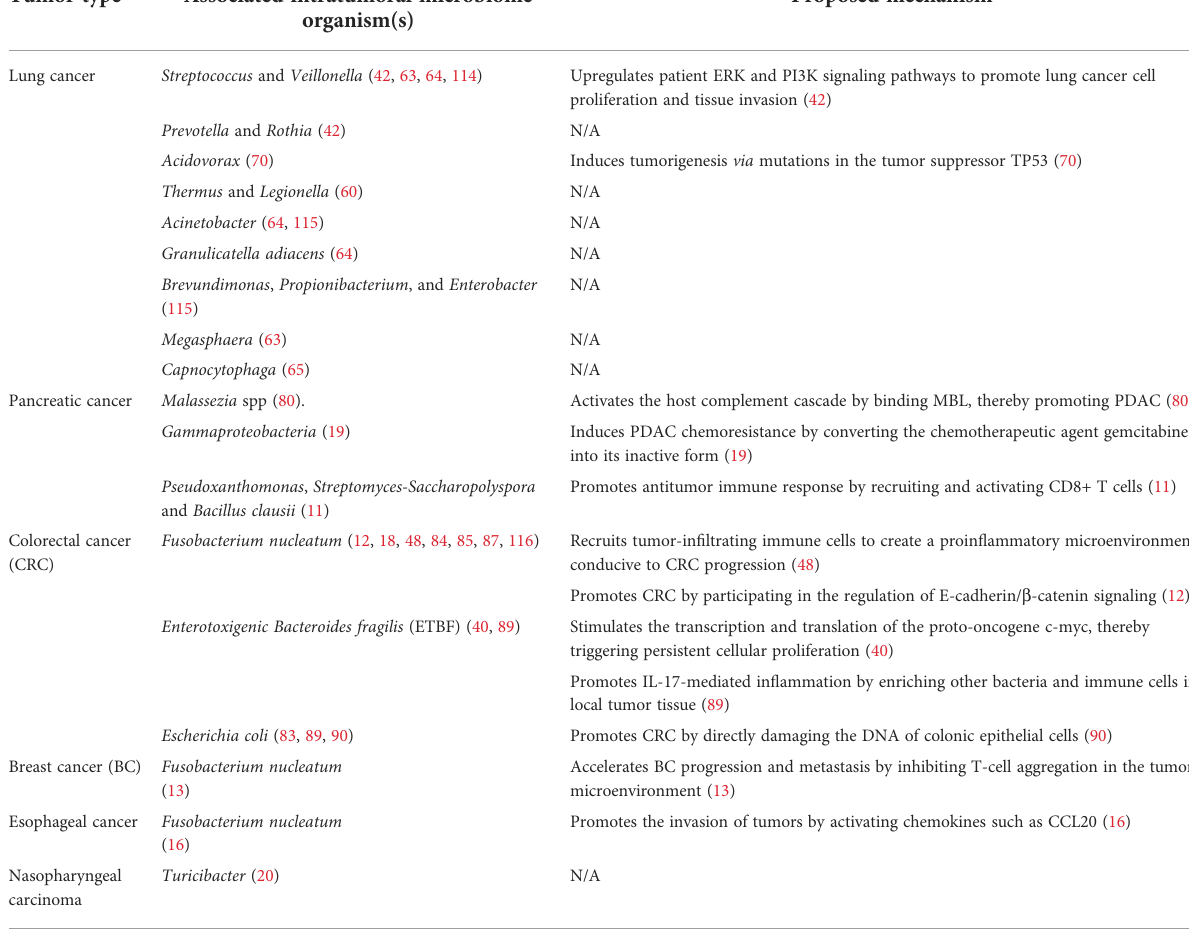
TABLE 1 Microbiotas in different cancer tissues and their effects on corresponding cancer tissues and mechanisms of action. Tumor